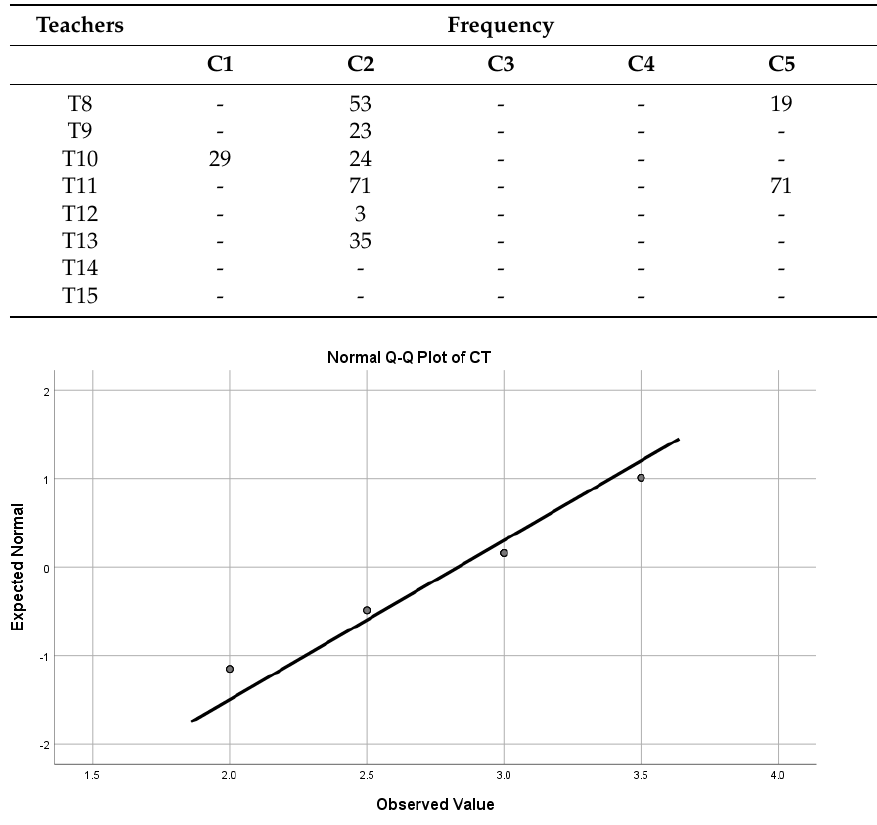
Figure 3. Normality test of